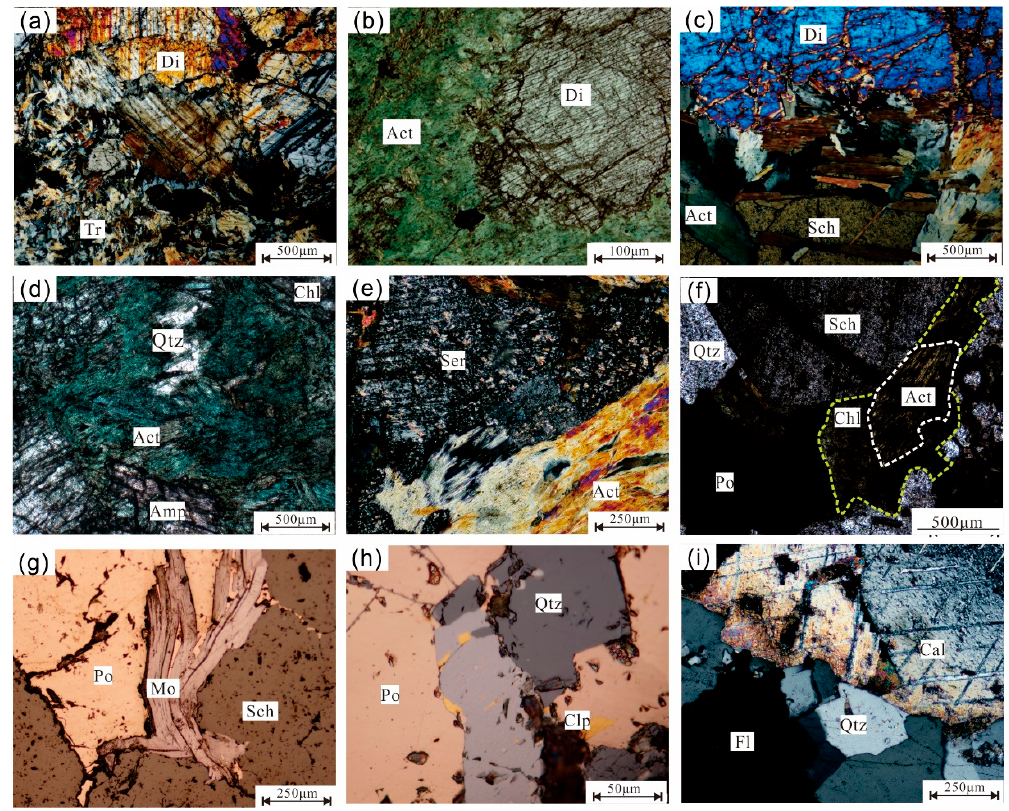
Figure 4. Reflected- and transmitted-light photomicrographs showing the typical morphology and textures of ore and gangue minerals in the Shangfang W deposit. ( a ) diopside and tremolite coexist in the early stage; ( b ) the diopside was altered to actinolite; ( c ) actinolite coexists with the early-stage scheelite; ( d ) chloritization and silicification; ( e ) Sericite alternated from plagioclase; ( f ) chlorite alternated from amphibole; ( g , h ) the scheelite coexists with massive pyrrhotite, chalcopyrite and minor molybdenite; ( i ) calcite and fluorite. Abbreviations: Di = Diopside; Tr = Tremolite; Act = Actinolite; Sch = Scheelite; Qtz = quartz; Ser = sericite; Po = Pyrrhotite; Chl = Chlorite; Mo = molybdenite; Clp = Chalcopyrite; Cal = calcite; Fl = fluorite.